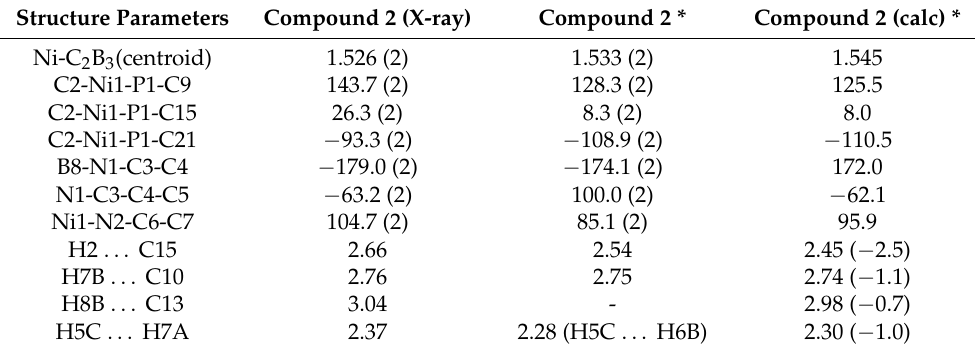
Table 1. Selected torsion angles (deg.), Ni-C 2 B 3 (centroid) distance and nonbonded intramolecular shortened contacts (Å) that define molecular conformation for experimental (X-ray) and calculated structure of complex 2 and comparison with 2* .